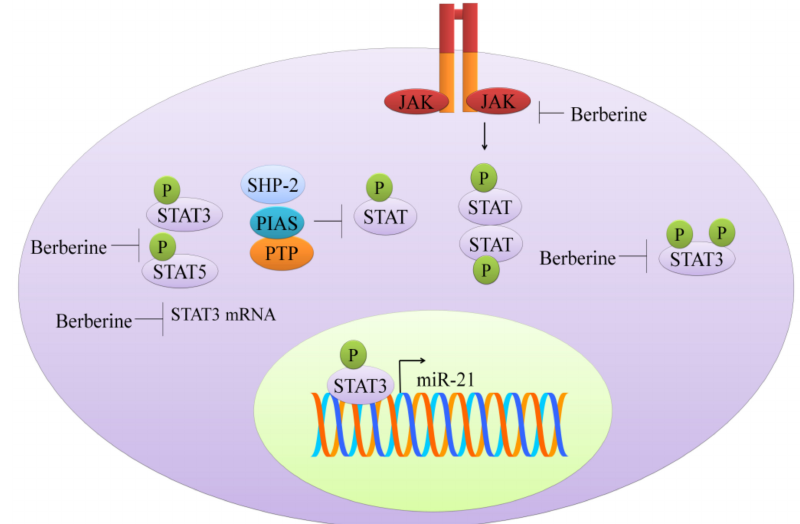
Figure 2. JAK-STAT signaling. Berberine has been shown to inhibit phosphorylation of STAT3 and STAT5. Berberine markedly reduced mRNA levels of STAT3. Functionally active STAT3 moved into the nucleus and stimulated expression of miR-21. Abbreviations: STAT (signal transducer and activator of transcription), JAK (Janus kinase), PIAS (Protein inhibitors of activated STATs), PTP (Protein-tyrosine phosphatase), SHP-2 (Src homology